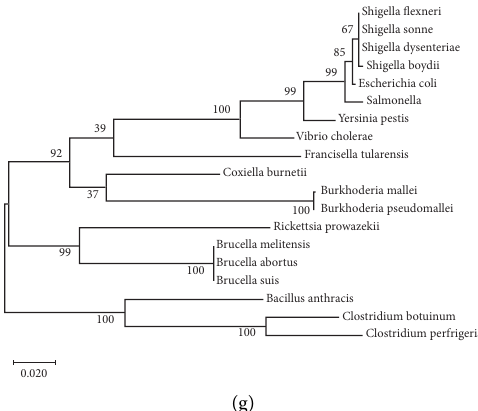
Figure 1: Phylogenetic tree of concatenated sequences of the 16S rRNA gene regions. The consensus sequences from the species described in Table 1 were aligned according to the variable region of 16S rRNA gene. Trees were generated using maximum likelihood, Kimura-2- parameter, gamma substitution, and bootstrap of 1000 replicates. (a) Variable regions (V1V2); (b) variable regions (V4V5); (c) variable regions (V6V7V8); (d) variable regions (V1V2 and V4V5); (e) variable regions (V1V2 and V6V7V8); (f) variable regions (V4V5 and V6V7V8); and (g) variable regions (V1V2, V4V5, and V6V7V8). The black dots indicate species that were not discriminated by specified regions to a monophyletic group.